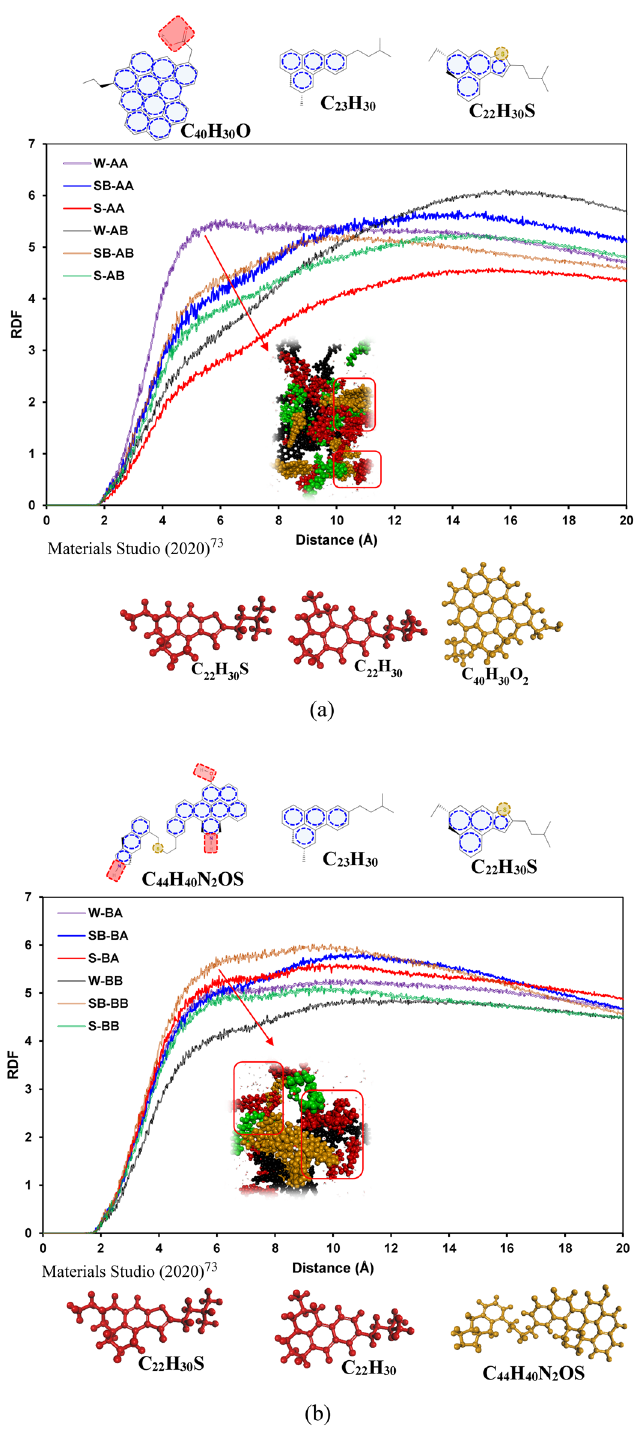
Figure 4. RDFs of the asphaltene–resin molecule pairs containing ( a ) C 40 H 30 O 2 and ( b ) C 44 H 40 N 2